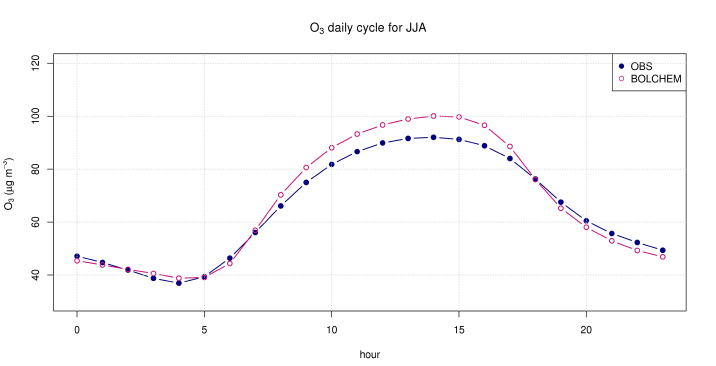
Figure 6. Hourly mean ozone concentration averaged overall background station for the summer season. Observations (blue curve) and modeled concentrations (red curve) are